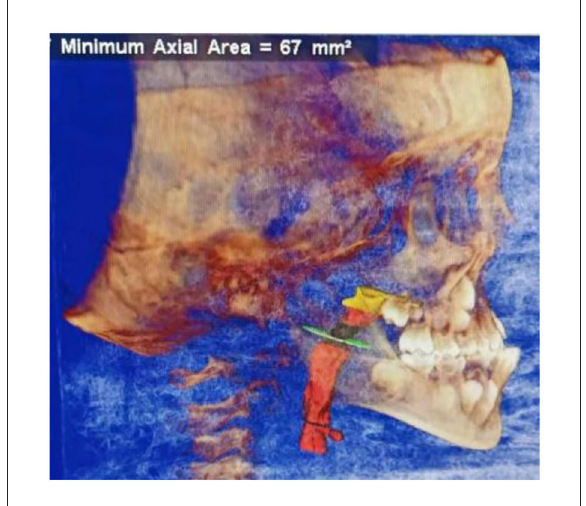
FIGURE4 Three-dimensional reconstruction of